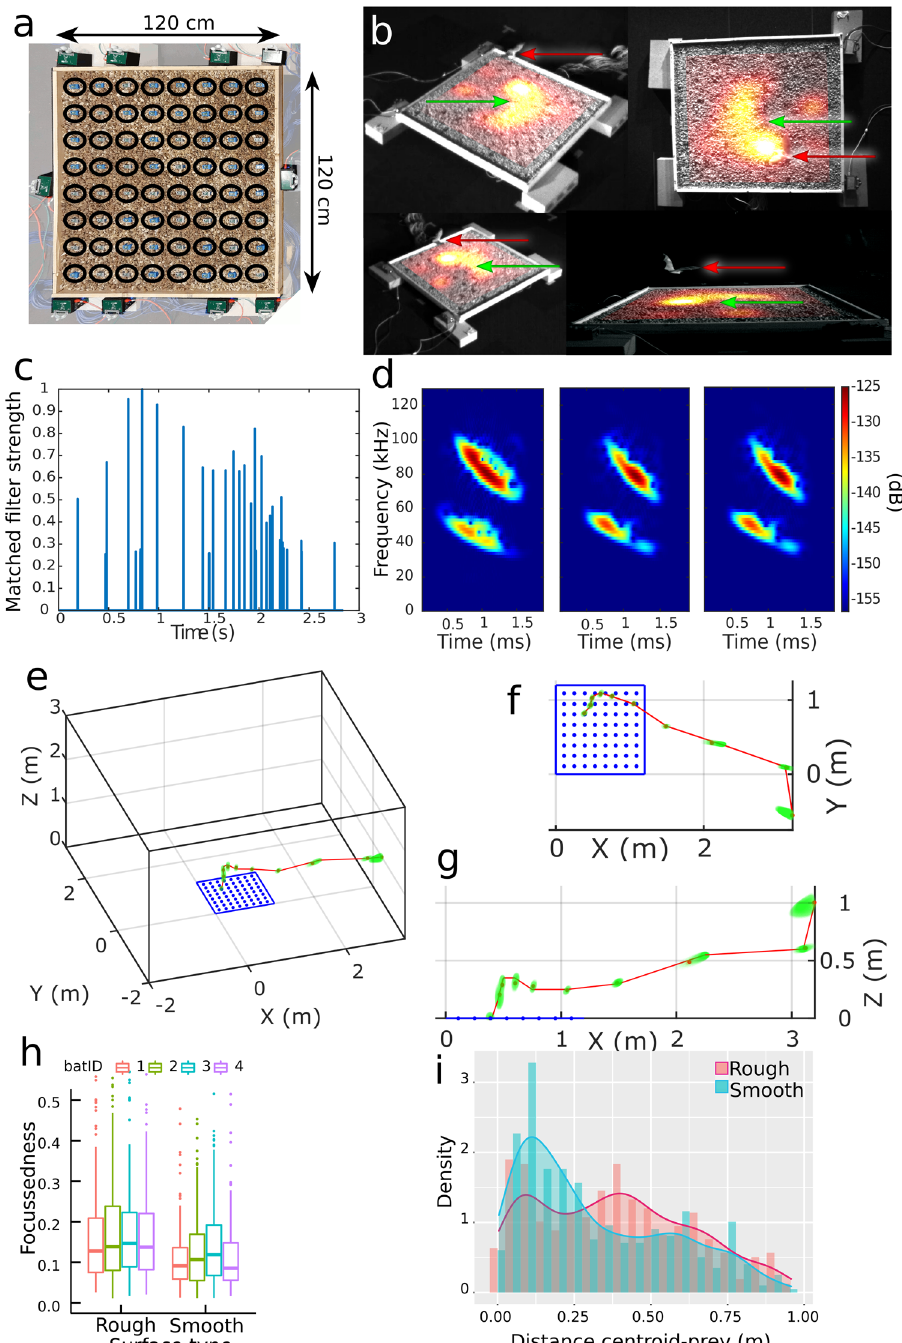
Fig. 3 Hunting behavior of pallid bats ( Antrozous pallidus ) attacking scorpions ( Hadrurus arizonensis ). These experiments were performed at the Barber Sensory Ecology Lab at Boise State University, Idaho, USA. a Microphone array setup used in this experiment with a uniformly spaced rectangular grid of 64 single microphone units. The microphones were embedded in a layer of small rocks to mimic a natural background. b Four frames of simultaneous video recordings made from different viewpoints around the array. The acoustic intensity of the echolocation beam is shown in a color gradation overlay (yellow are high intensities, red are lower intensities). The red arrow indicates the position of the bat; the green arrow indicates the position of the scorpion. c Matched fi lter output indicating the temporal pattern of the echolocation signals during approach. d Three representative spectrograms of echolocation signals during the approach as indicated in ( c ). e – g Flightpath from one approach calculated by comparison of the TDoA of the bat calls. e A 3D view of the fl ightpath. The dimensions of the fl ight room are represented by the black vertices. f Top view and g side view of the same fl ightpath. For each bat call, the position of that call is indicated by a red marker. The surrounding green markers indicate the uncertainty or error on the position. The consecutive calls have been connected by a red line to indicate their order and show an estimate of the fl ight path. h Level of focus of the call for both surface types. We show the level of focus of four individual bats on both surface types. n values from left to right: 228, 252, 221, 265, 168, 233, 309, 111. i Distribution of the centroid distance of the bats ’ scanning pattern to the scorpion ’ s location for both the rough and the smooth surface. We used a threshold value for the level of focus of 0.5 to represent the calls in this fi gure. See Supplemental Fig. S5 for a more complete visualization of the fl ight